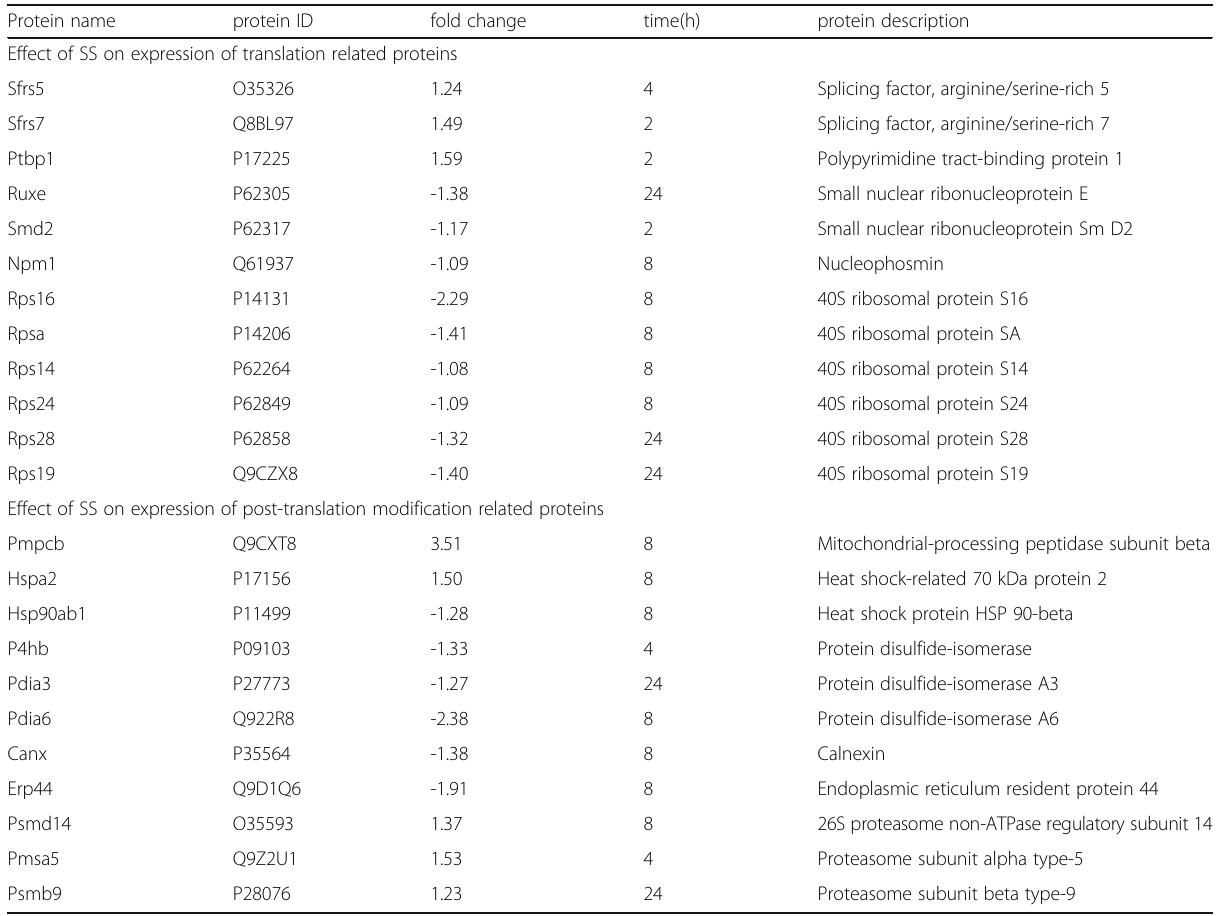
Table 3 Effects of SS on expression of protein metabolism related proteins Protein